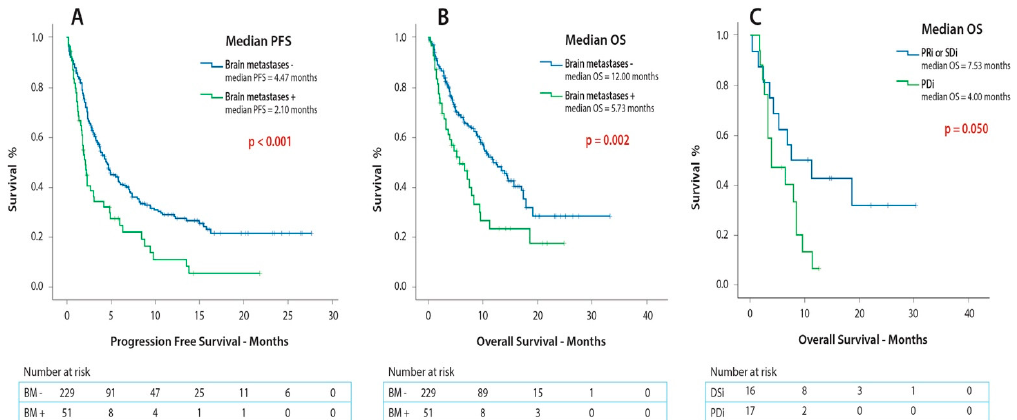
Figure 4. Kaplan-Meier curves on the effect of ( A ) Presence of brain metastases on PFS ( B ) Presence of brain metastases on OS ( C ) Achieving intracranial disease stabilization as a first response to ICI administration on OS. Abbreviations: ICI = Immune Checkpoint Inhibitor, PFS = Progression-Free Survival, OS = Overall Survival, PRi = Intracranial Partial Response, SDi = Intracranial Stable Disease, PDi = Intracranial Progressive Disease.